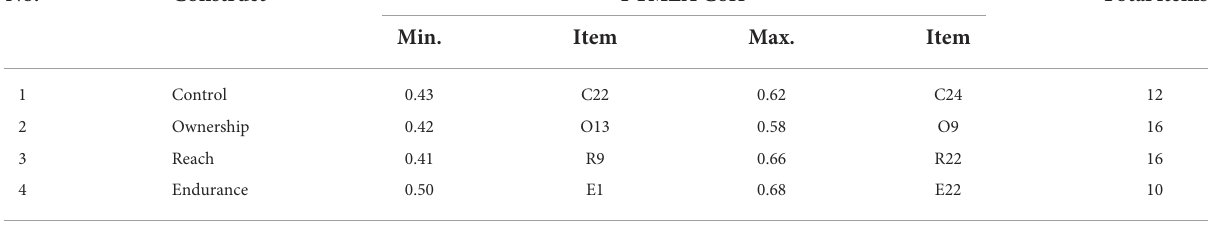
TABLE 5 Polarity of AQ construct items.